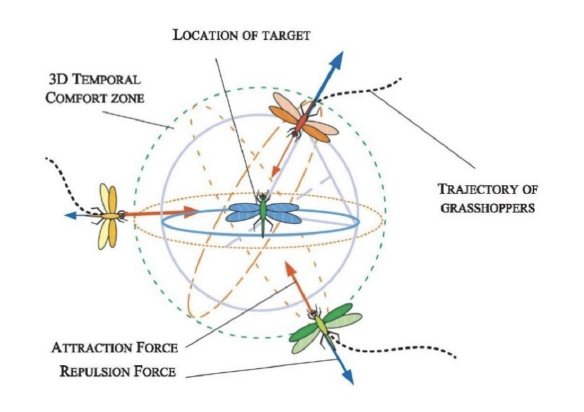
Fig. 6. rimitive corrective patterns between individuals in a swarm